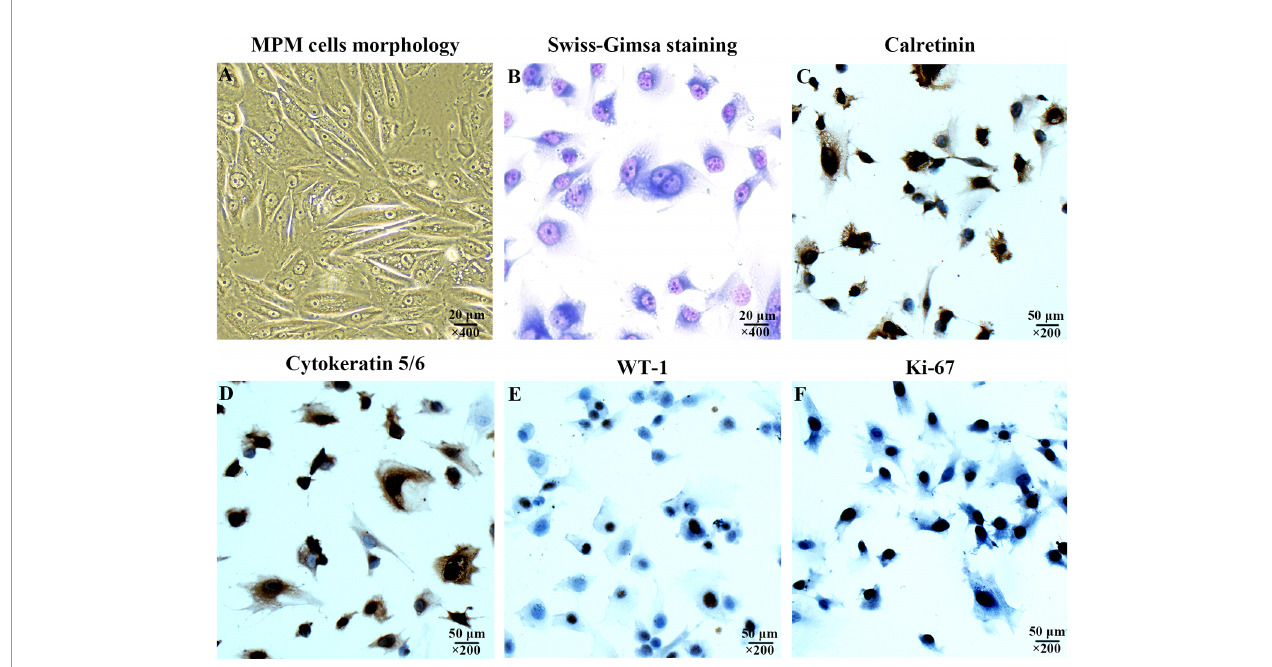
FIGURE 1 | Characterization of the cultured human malignant peritoneal mesothelioma (MPM) cells. (A) MPM cells morphology under inverted phase contrast microscope, magni fi cation, ×400. (B) MPM cell morphology was observed by Swiss-Giemsa staining, magni fi cation, ×400. (C) The expression of Calretinin in MPM cells was con fi rmed by immunocytochemical staining, magni fi cation, ×200. (D) The Cytokeratin 5/6 was positive, magni fi cation, ×200. (E) The expression of WT-1 was positive, magni fi cation, ×200. (F) The expression of Ki-67 was positive, magni fi cation,